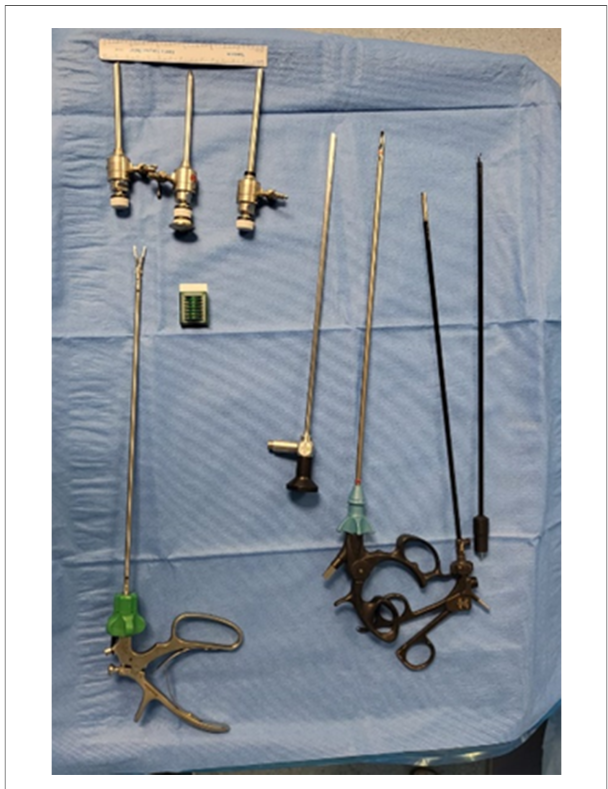
FIGURE 1 Reduced number of reusable instruments used to perform emirate cholecystectomy (karl storz SE & Co. KG, Tuttlingen,